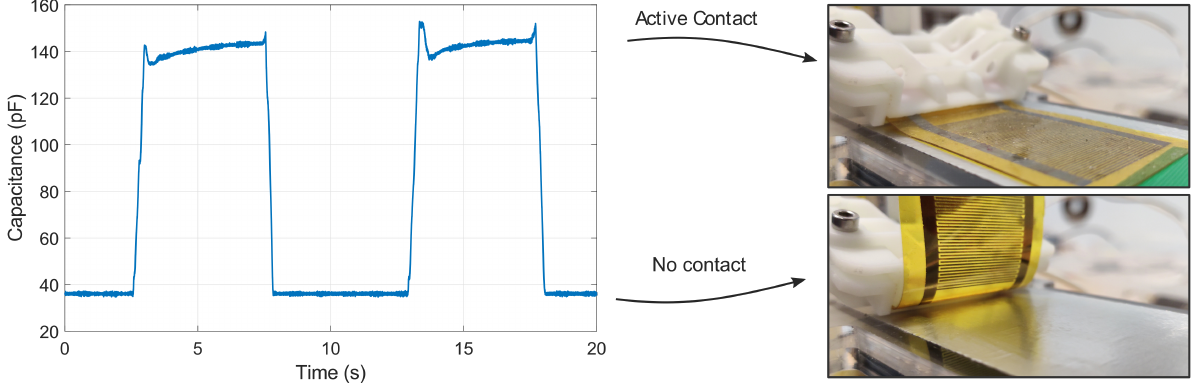
Figure 7. Adhesion feedback on an aluminum substrate. The pad was manually attached and detached to/from the substrate material, while the capacitance-based self-sensing feature provides online feedback on the contact